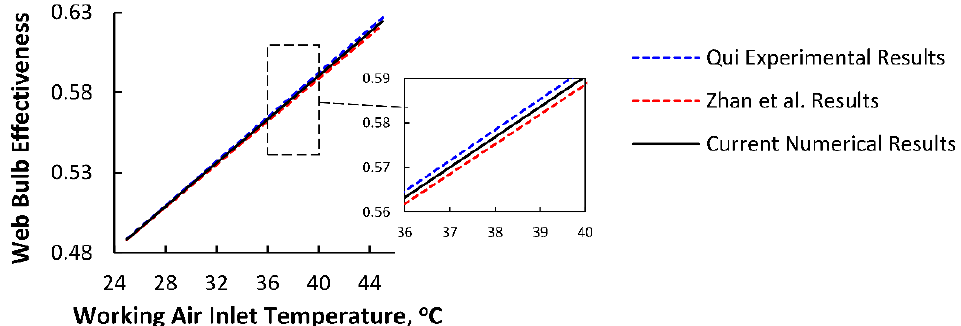
Figure 5. Validation of results (Part II): comparison of numerical results with the experiment results from Qui [45] and numerical results from Zhan et al. [14] for RH = 35%, dry bulb temperature of working air = 25 °C to 45 °C, and volume flow rate = 130 m 3 /h.